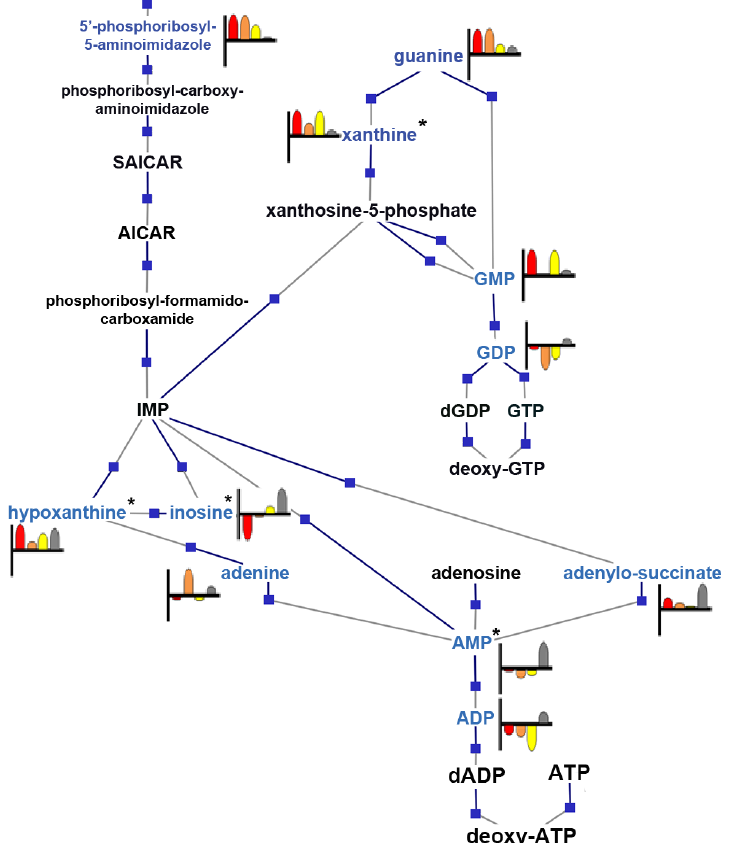
YeastCyc and enriched with the annotated feature and MS/MS ( * ) identified compound results. Metabolites detected are highlighted in blue and accompanied by a heat strip that shows log2 normalized relative abundance as detected per treatment condition; from left to right: calcium, red; CsA, orange; FK506, yellow; wild-type, grey. Boxes indicate gene/enzyme interaction nodes, which contain the genes described, but are not